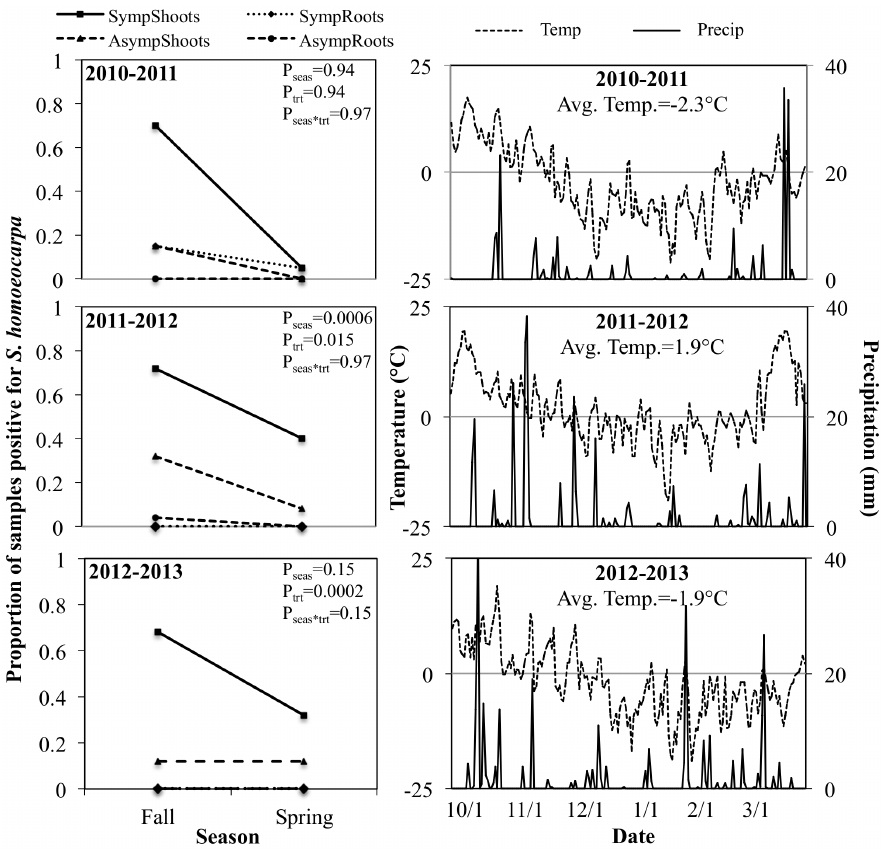
Figure 1. Sclerotiniahomoeocarpa isolation and weather data for pathogen overwintering studies. Roots and shoots were collected from symptomatic and asymptomatic turf in the fall of each year to determine starting S. homoeocarpa populations. The same areas were resampled in the spring to assess pathogen survival. ANOVA values for season, treatment, and season by treatment effects are reported for each year. Weather data includes daily air temperature (dashed line) and precipitation (solid line) averages. The average temperature in 2011–2012 was c. 4 u C higher than